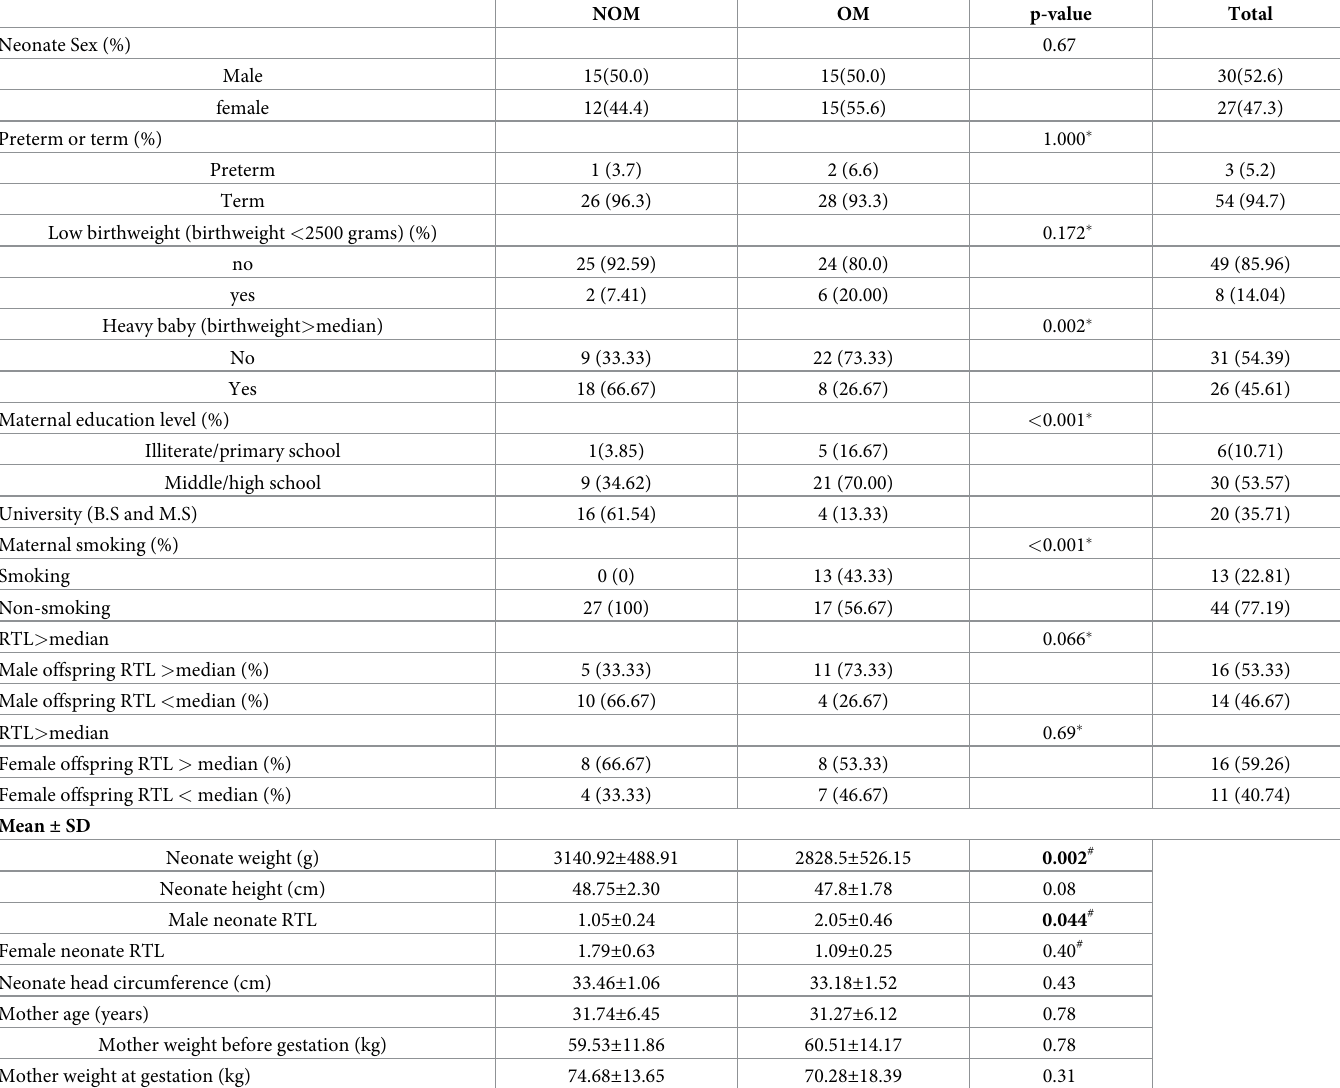
Table 1. Baseline characteristics of the study population by maternal regular opioid